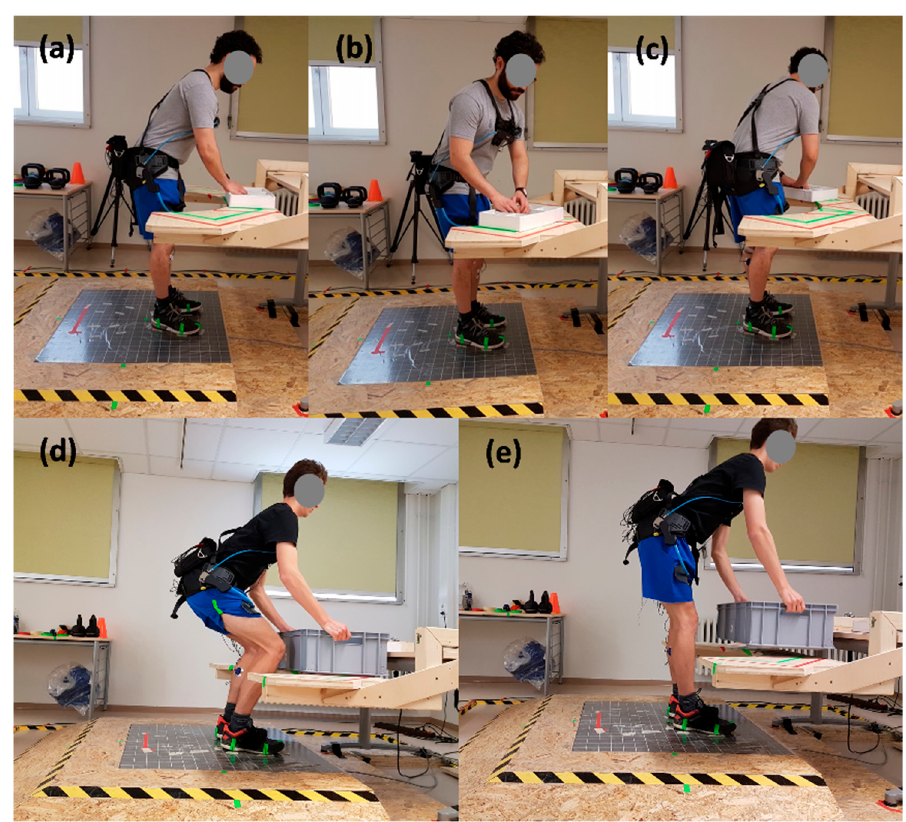
Figure 3. Subjects performing the experimental work tasks using the exoskeleton. ( a – c ) [16] show the static sorting task in three Trunk orientation conditions: ( a ) frontal, ( b ) right orientation, ( c ) left orientation. ( d , e ) show the dynamic lifting task to the front, performing ( d ) the squat style and ( e ) the stoop style.